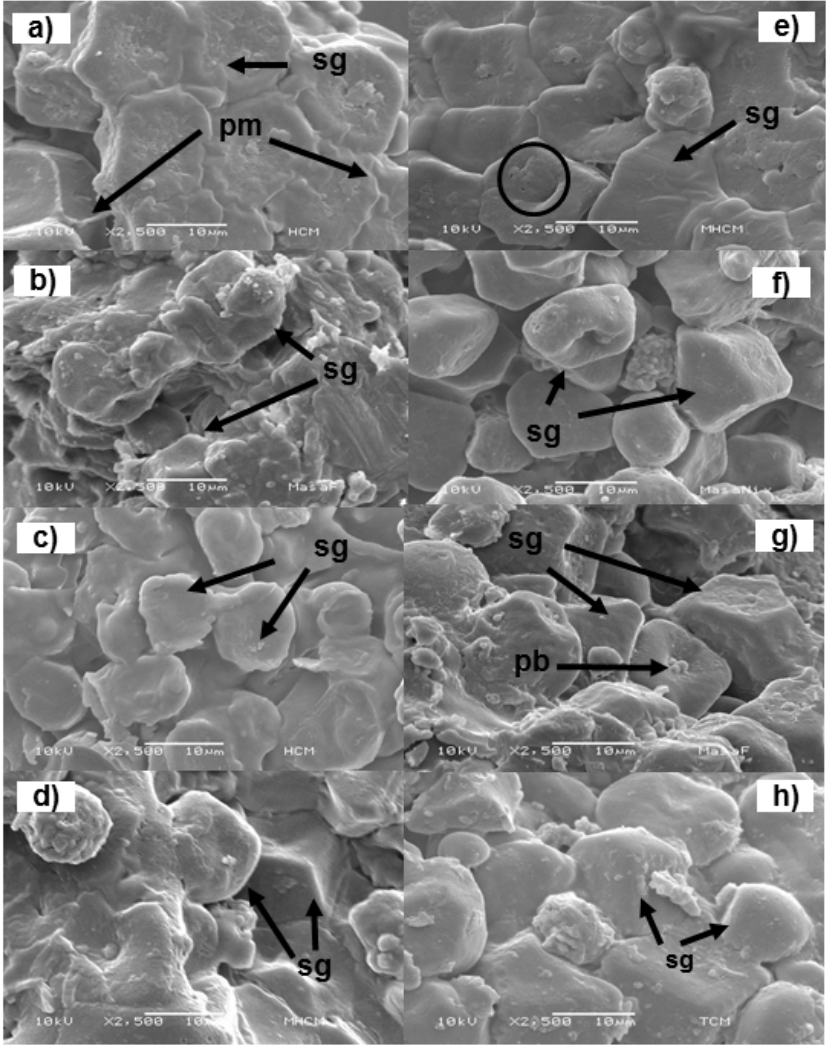
Figure 6. Scanning electron microscope (SEM) images of nixtamalized corn flours and corn tortilla flours obtained by the industrial ( a – d ) and traditional methods ( e – h ). ( a ) Commercial nixtamalized corn flour, ( b ) commercial corn tortilla flour without refrigeration, ( c ) commercial corn tortilla flour stored at 4 ◦ C for 7 days, ( d ) commercial corn tortilla flour stored at 4 ◦ C for 30 days, ( e ) traditional nixtamalized corn flour, ( f ) traditional corn tortilla flour without refrigeration, ( g ) traditional corn tortilla flour stored at 4 ◦ C for 7 days, ( h ) traditional corn tortilla flour stored at 4 ◦ C for 30 days. sg = starch granules, pm = protein matrix, pb = protein